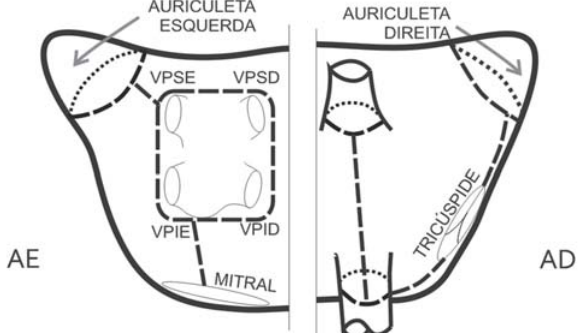
Fig. 1 - Desenho esquemático sobre técnica de ablação utilizada no trabalho